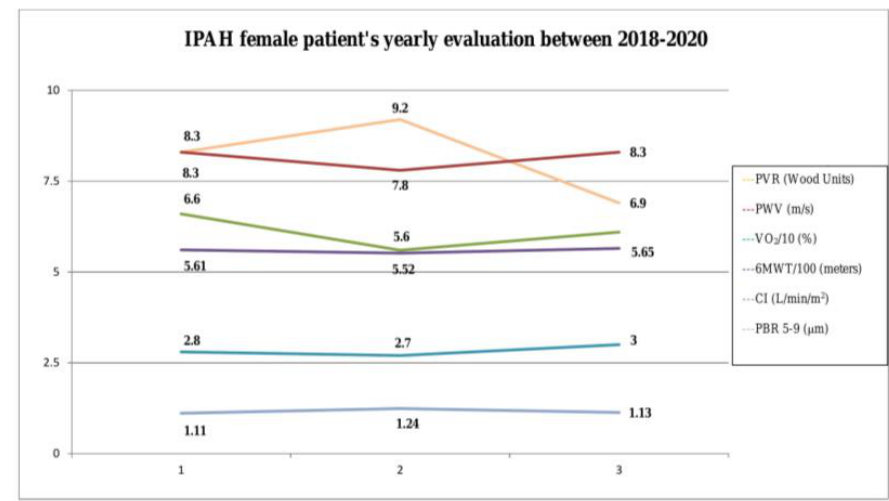
Figure 1. Annual changes in hemodynamic, exercise and systemic circulation indices. (Abbreviations: PVR, pulmonary vascular resistance; PWV, pulse wave velocity; VO 2 , oxygen consumption, 6MWT, six-minute walking test; CI, cardiac index; PBR, perfused boundary region.).